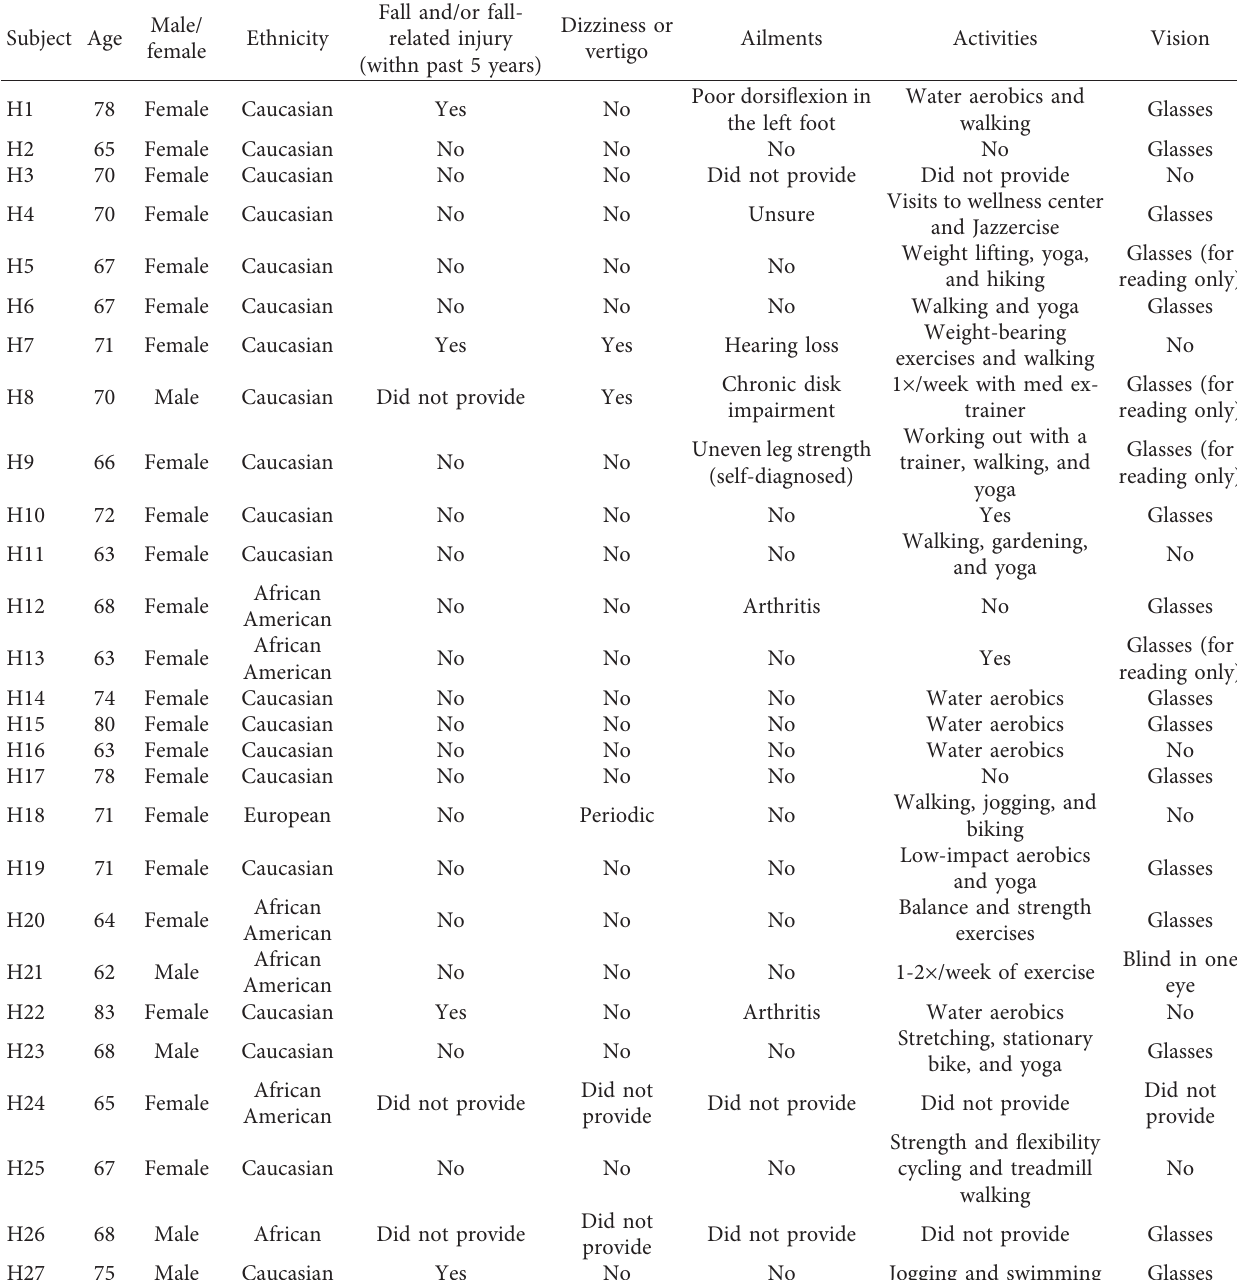
Table 2: Demographics of healthy